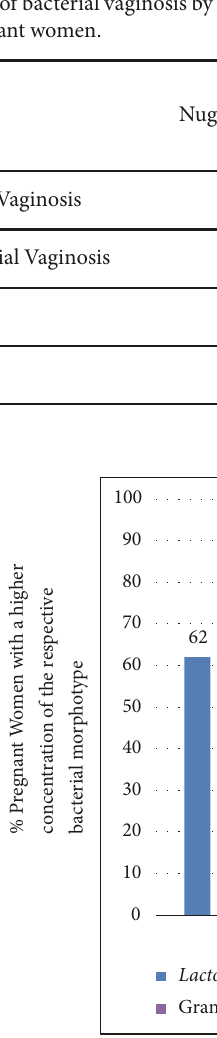
Figure 1: Bacterial profile in pregnant women with normal Nugent score (0-3) (n=349), intermediate score (4-6) (n=121), and bacterial vaginosis (Nugent score 7-10)